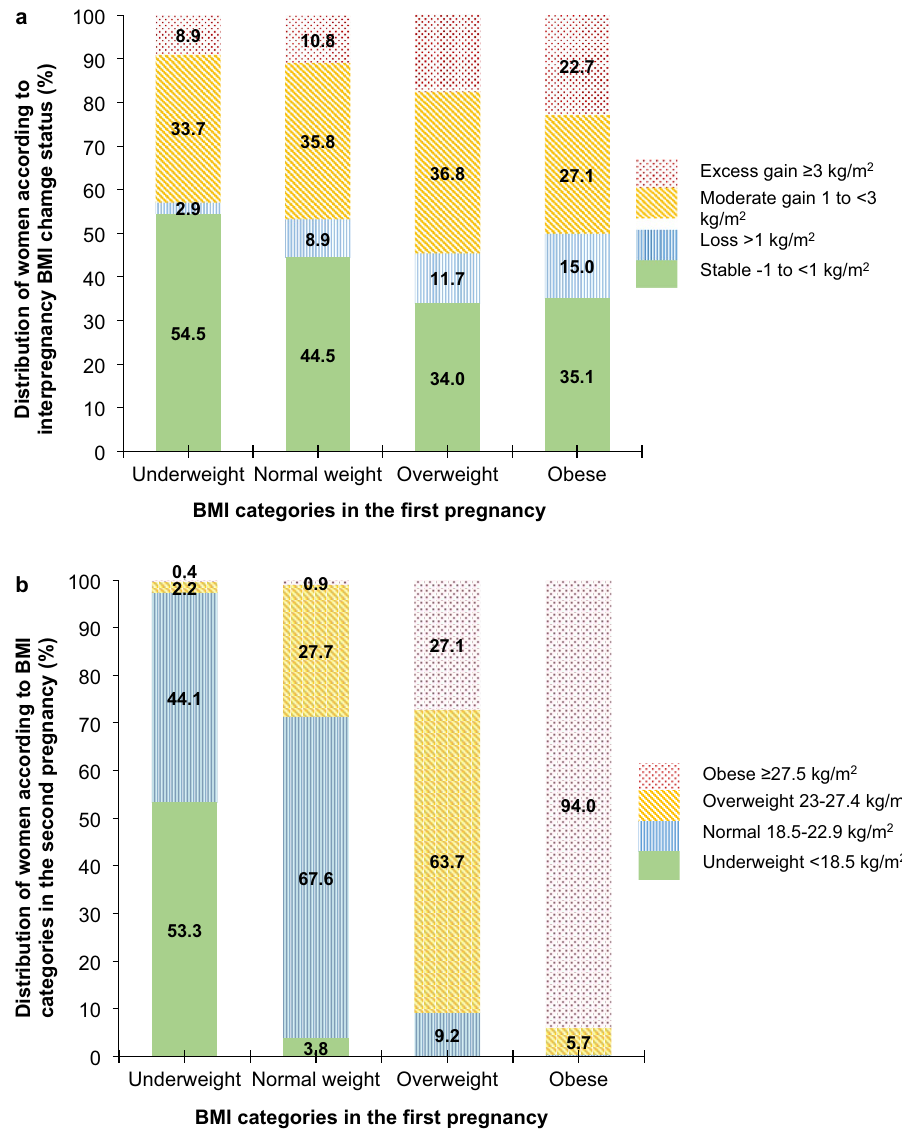
Figure 2. Interpregnancy BMI change status and BMI categories in the second pregnancy by BMI categories in the first pregnancy. Bar chart showing the distribution of (a) body mass index (BMI) change status between first two pregnancies and (b) BMI categories at 12-week gestation in the second pregnancy, by BMI categories of women at 12-week gestation in the first pregnancy (n = 6264). BMI categories were classified based on the cut- offs for Asian populations. BMI, body mass